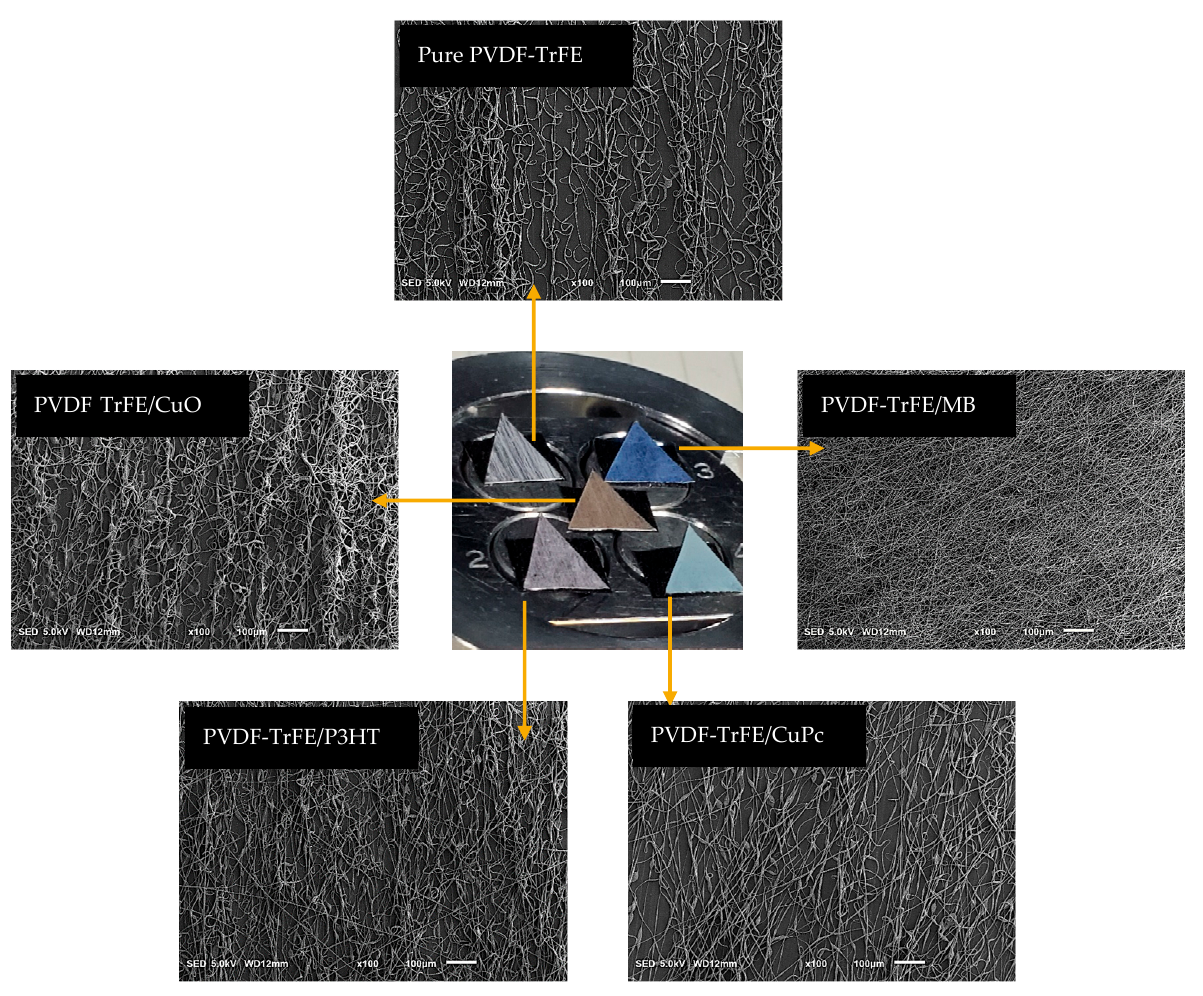
Figure 1. Di ff erent PVDF-TrFE electrospun fi brous membranes with electroconductive phases: qual- Figure 1. Different PVDF-TrFE electrospun fibrous membranes with electroconductive phases: itative evaluations. qualitative